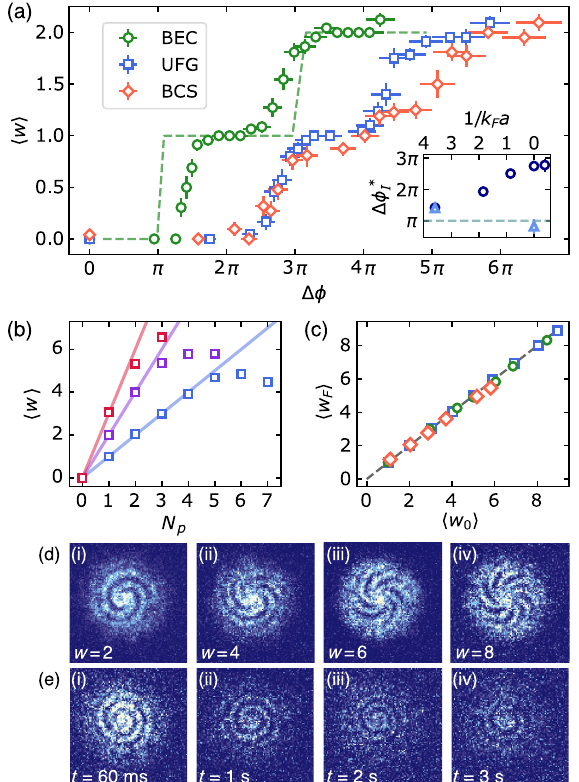
FIG. 3. Persistent currents with on-demand circulation in the BEC-BCS crossover. (a) Average winding number h w i , measured over20interferogramsacquiredaftertheimprintingofaphasejump Δ ϕ a ≃ f 3 . 6 ; 0 ; − 0 . 4 g , for the three interaction regimes of 1 =k I F labeled as BEC, UFG, and BCS, respectively. The interferograms are acquired60msafter theend ofthe imprintingpulse. Alldatasets are obtained by varying the imprinting time at constant U 0 in each regime. The green dashed line represents GPE numerical simu- lations of our imprinting protocol, performed under the same experimental conditions of the BEC superfluid. Inset: imprinted (see text) as a function of the interaction strength phase jump Δ ϕ (cid:2) I for simple gradient imprinting (dark blue circles) and modified by adding a barrier at the discontinuity (light blue triangles). The gray dashed line marks Δ ϕ (cid:2) ¼ π , as expected from GPE numerical I simulation. Vertical error bars denote the standard error of mean (SEM); horizontal ones are instead obtained by considering the experimental uncertainty of 5% in the U 0 calibration. (b) Average circulation of a unitary superfluid measured after a variable number 1 (blue), 2 (purple), and 3 N ofidentical imprinting pulses of w p i ¼ (red) each separated 10 ms from the following. The solid lines × N . (c) Average circu- represent the linear scaling of h w i ¼ w i p lation h w measured after a long time evolution of the initially F i imprinted state h w 0 i forthe threeinteraction regimes[same notation as in panel (a)]. We measure h w 0 i and its SEM 60 ms after the after 1.5 s for h w 0 i ≤ 3 , after 1 s for imprinting pulse and h w F i ≤ 6 , and after 0.5 s for h w 6 in the BEC and UFG 3 < h w 0 i 0 i > is measured after 1 s and 0.5 s regimes. For BCS superfluids, h w F i for h w 0 i ≤ 3 and h w 0 i > 3 , respectively. (d) Interferograms of high circulation states, acquired for BCS (i, ii) and UFG (iii, iv) superfluids 60 ms after the last imprinting pulse. (e) Interferograms ofthe unitary superfluid in the w ¼ 1 state asa functionoftime after theimprintingpulse.Imagesin(d)[(e)]consistoftheaverageoftwo [single] independent experimental